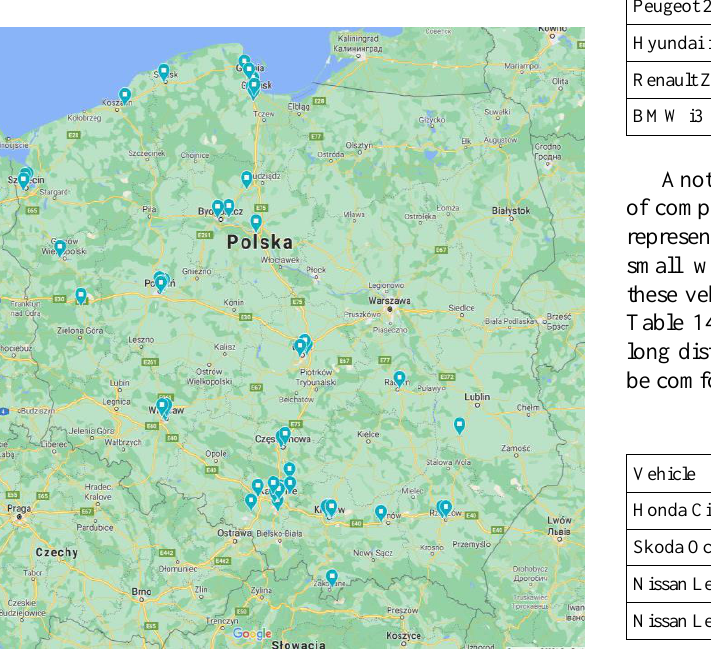
Fig. 1. Map of charging stations in Poland (provided by